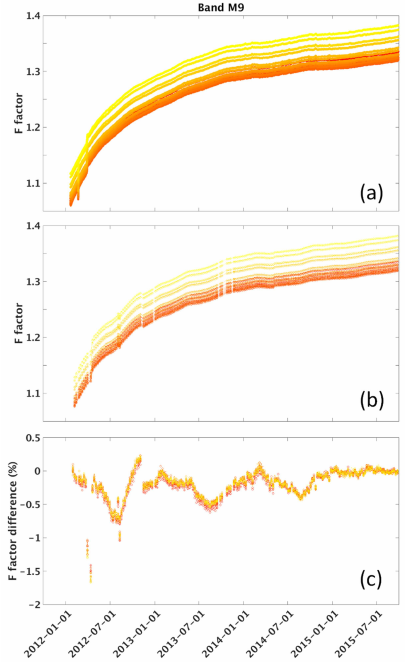
Figure A6. ( a ) VIIRS band M9 (1378 nm, single gain) radiometric calibration scaling coefficients (the F factors) derived by the automated calibration procedure; ( b ) the F factors used in the operational production of the VIIRS SDR; and ( c ) relative difference between the operational F factors and the reprocessed ones (used here as a baseline). Symbol legend is the same as in Figure 4.